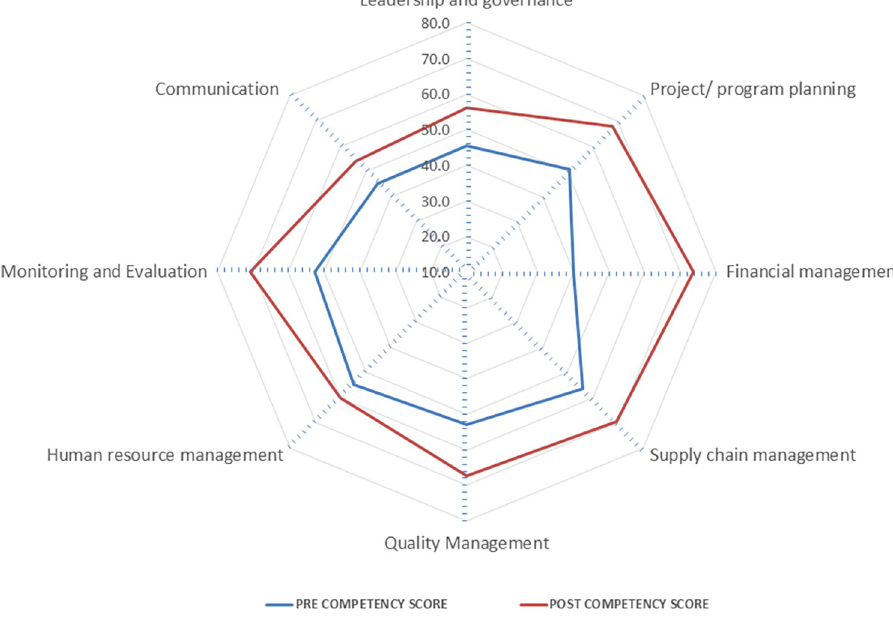
Fig 2. Pre post mean competency score of modules in International Public Health Management Development Program.